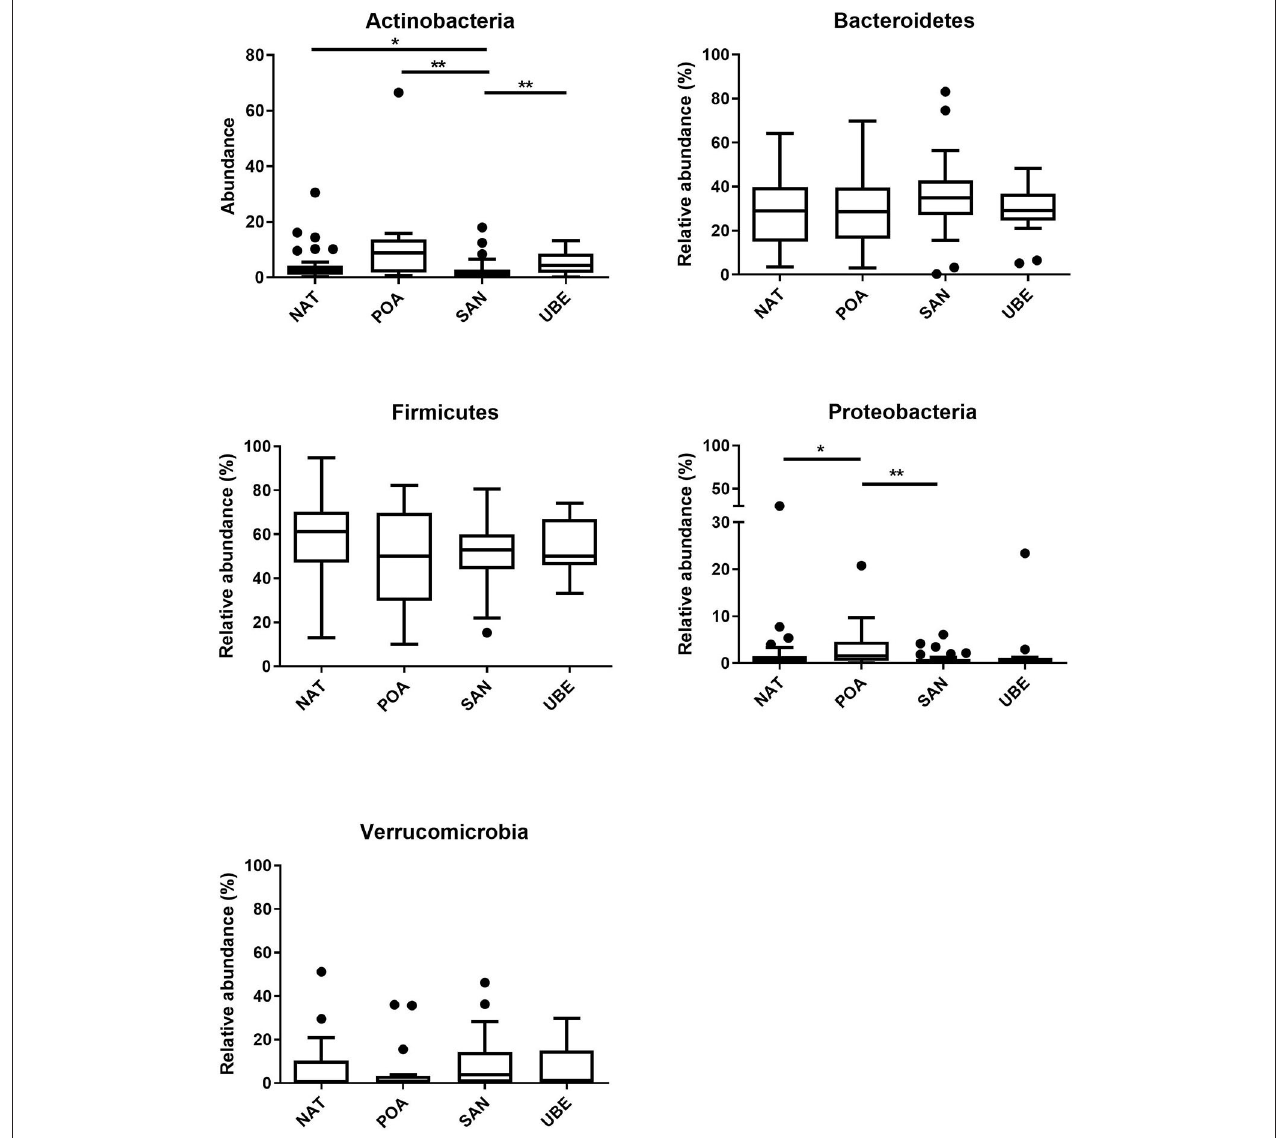
FIGURE 4 | Comparison of various phyla across the four regions reveals significant differences in Actinobacteria and Proteobacteria. Where * p < 0.05, ** p <